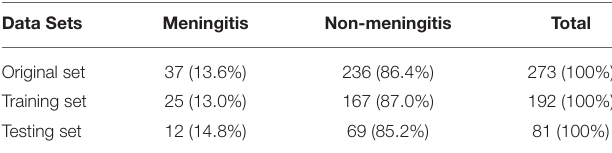
TABLE 1 | Distribution of lumbar drainage patients with and without meningitis in different data